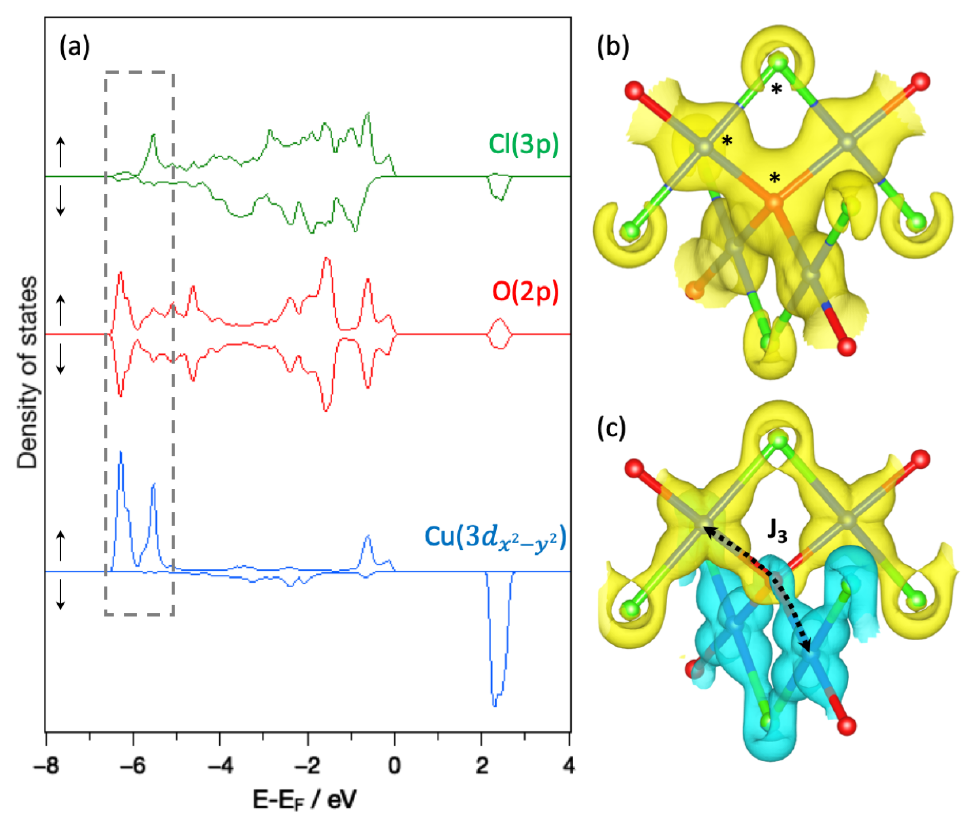
Figure 7. ( a ) Spin-polarized projected density of states (pDOS) of one plaquette in Cu 2 OCl 2 . The energy window of Cu-3 d x 2 − y 2 occupied states is evidenced by a gray dotted rectangle on the pDOS. The ( b ) electronic charge density and ( c ) the spin density calculated in this energy range are also displayed. The atoms considered for the pDOS are shown by black stars on the electronic charge density. Up and down spin channels of the pDOS are evidenced by ↑ and ↓ , respectively. Isovalues are set to 0.1 and 0.017 electron/Å 3 for electronic charge density and the spin density, respectively. Up and down regions of the spin density are highlighted in transparent yellow and cyan, respectively. Blue, red and green spheres indicate Cu, O and Cl atoms,